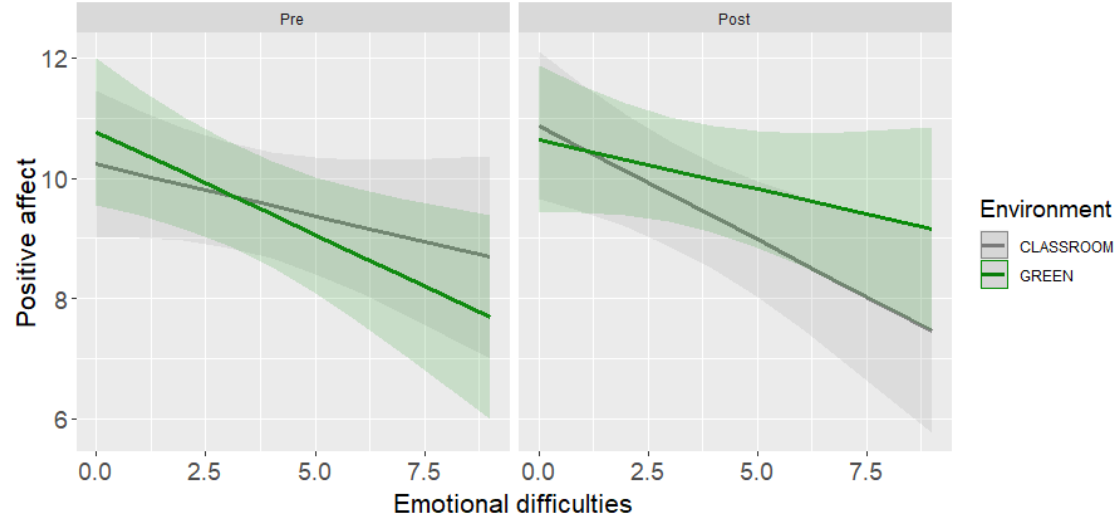
Figure 3. Interaction effect of environment, pre ‐ post positive affect, and emotional